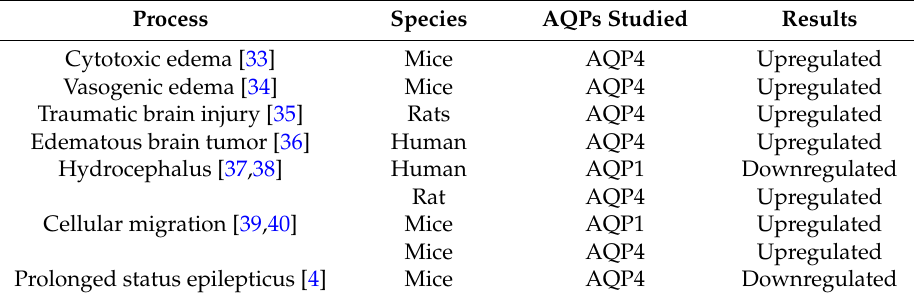
Table 1. Expression of AQP4 in different